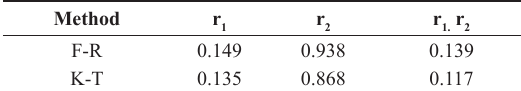
Table 2. Monomer reactivity ratios for PCMAEMA copolymer by F-R and K-T